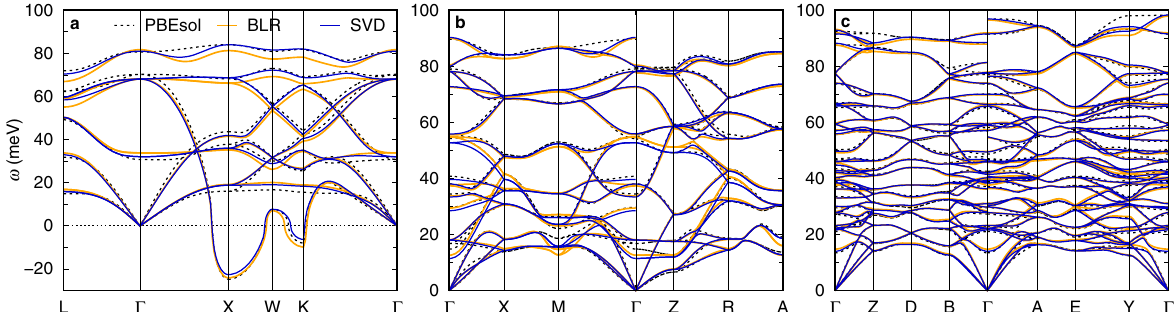
Fig. 3 Prediction of phonon frequencies. Phonon dispersions of a cubic, b tetragonal, and c monoclinic ZrO 2 along high-symmetry lines in the Brillouin zone. The results obtained using the MLFFs trained with BLR (orange lines) and SVD (blue lines) for the regression are compared with the AI ones calculated using PBEsol (dashed black